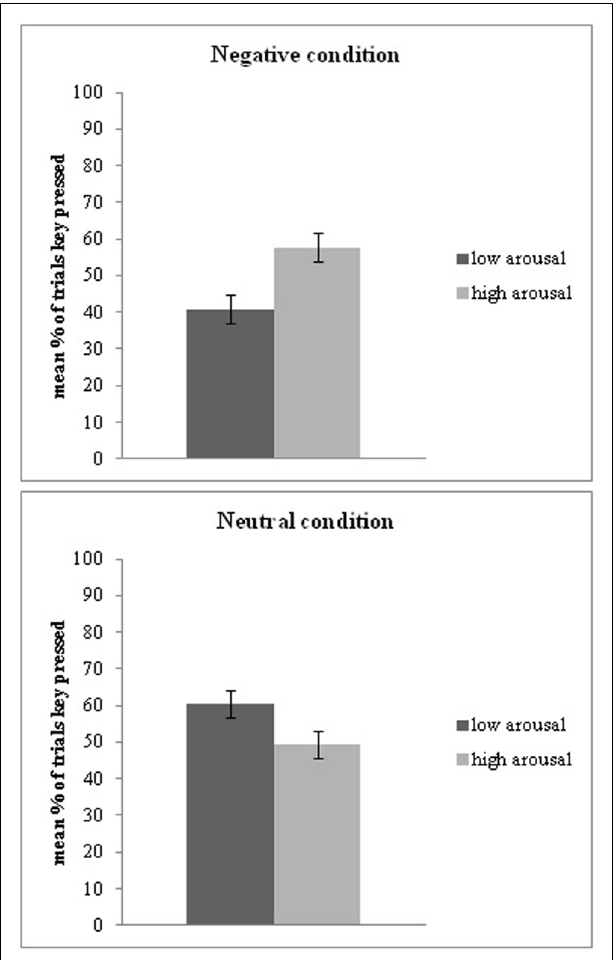
FIGURE 2 | Mean percentage of trials when the space bar was pressed is reported separately for negative and neutral pictures, with either low or high-arousal. People pressed the space bar significantly more for high-arousal negative pictures relative to low-arousal negative pictures. Within the neutral pictures, people pressed the space bar significantly more often for low-arousal in comparison to high-arousal pictures. Error bars reflect ± 1